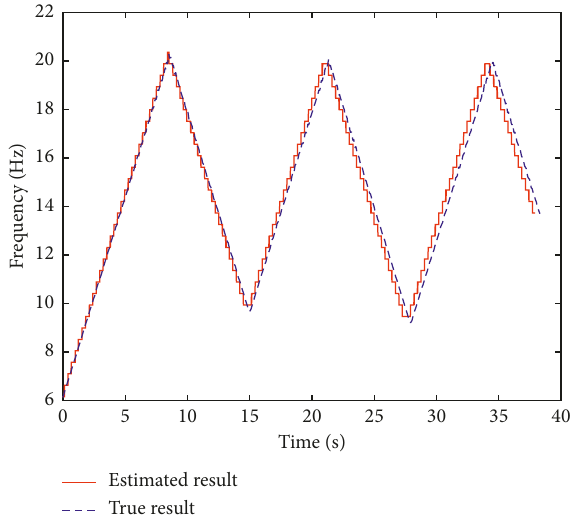
Figure 26: Comparison between estimated instantaneous rota- tional frequency and true result of rolling bearing vibration signal with fluctuated speed.